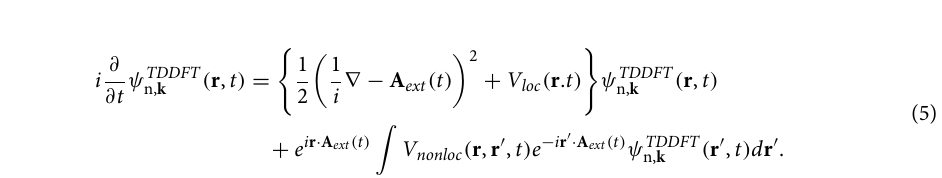
Table 1. Values of | E 0 | combined with fluence (J/cm 2 ) and FWHM (fs) used in the present work.